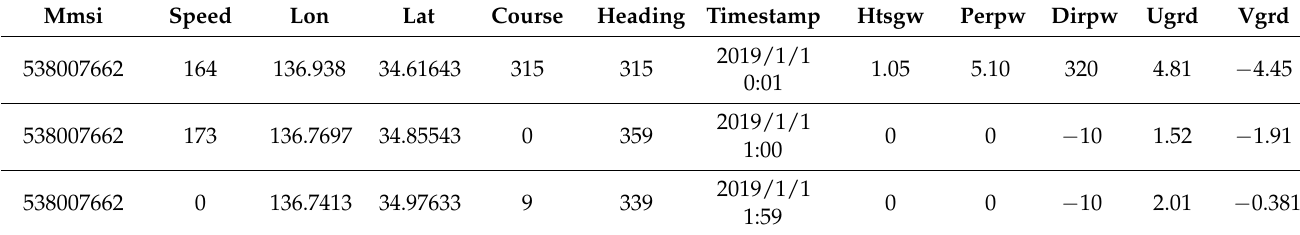
Table 2. Example of past vessel data.